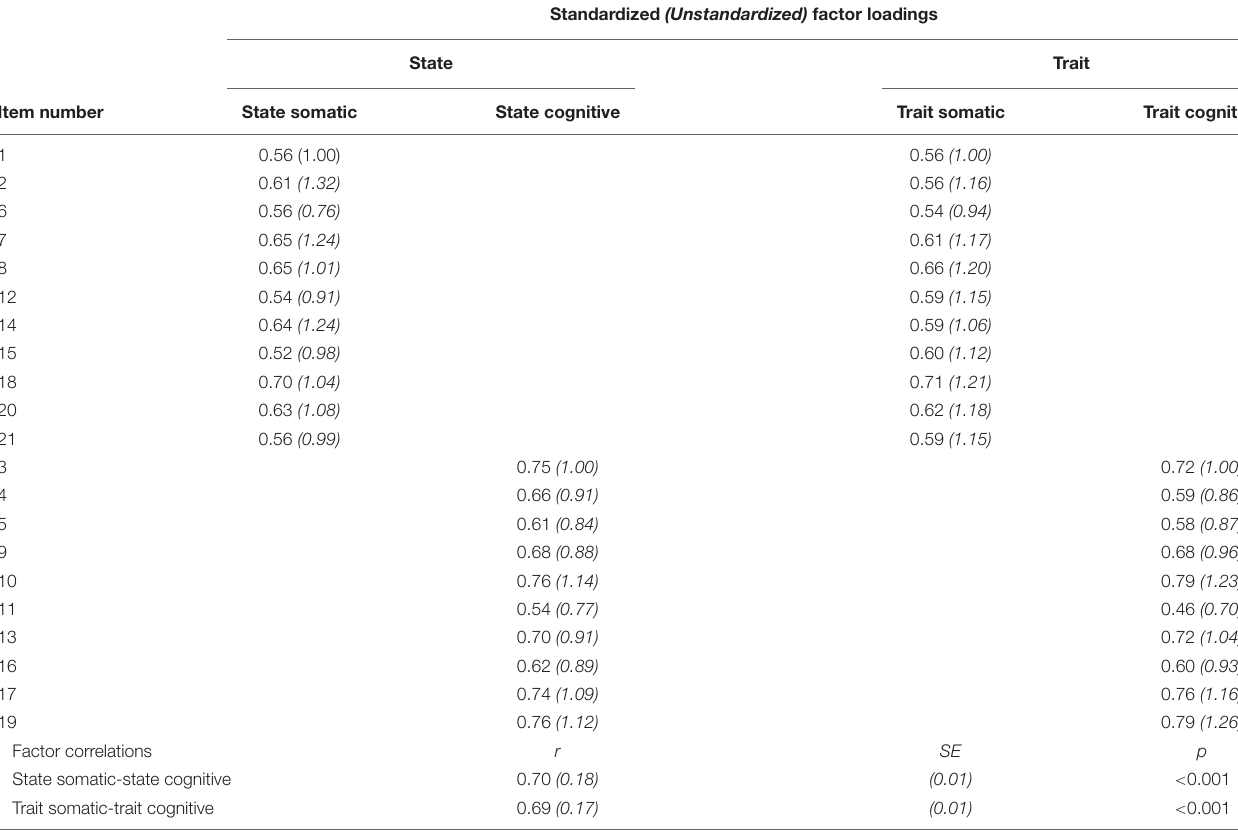
TABLE 2 | Factor loadings for the STICSA state: two factors (somatic and cognitive) and STICSA trait: two factors (somatic and cognitive) model.